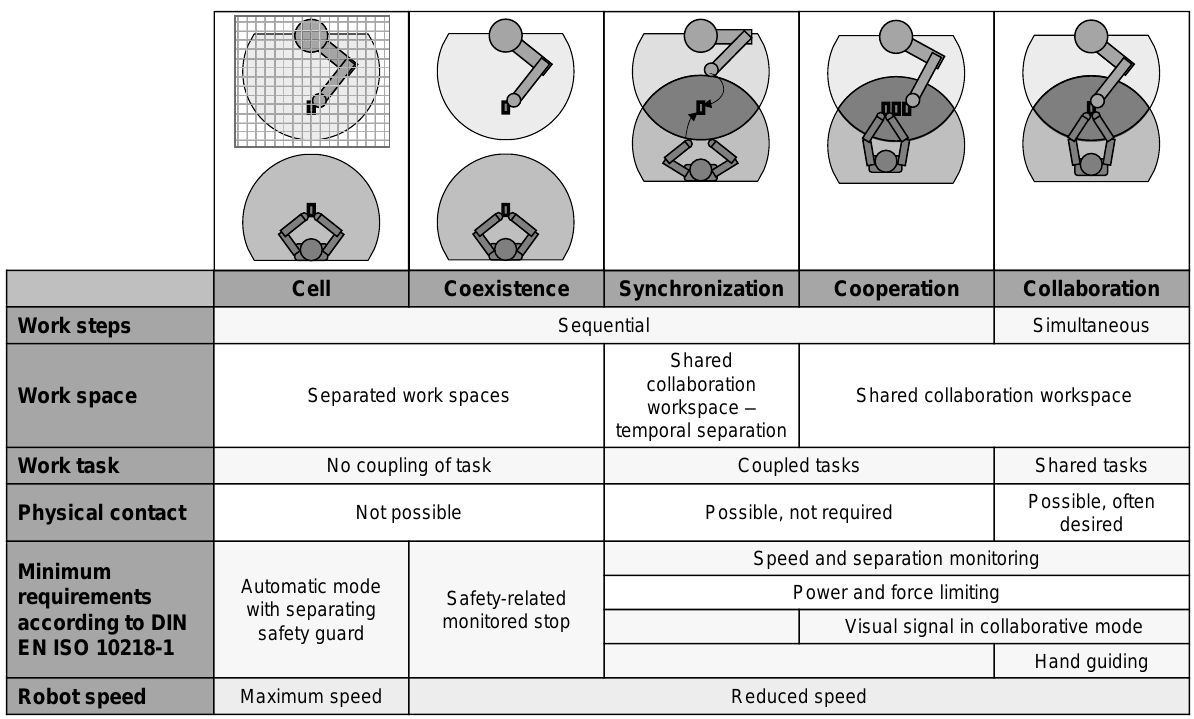
Figure 1. Overview of the levels of cooperation between humans and robots and their characteristics (according to [18,33]; translated from [34]).